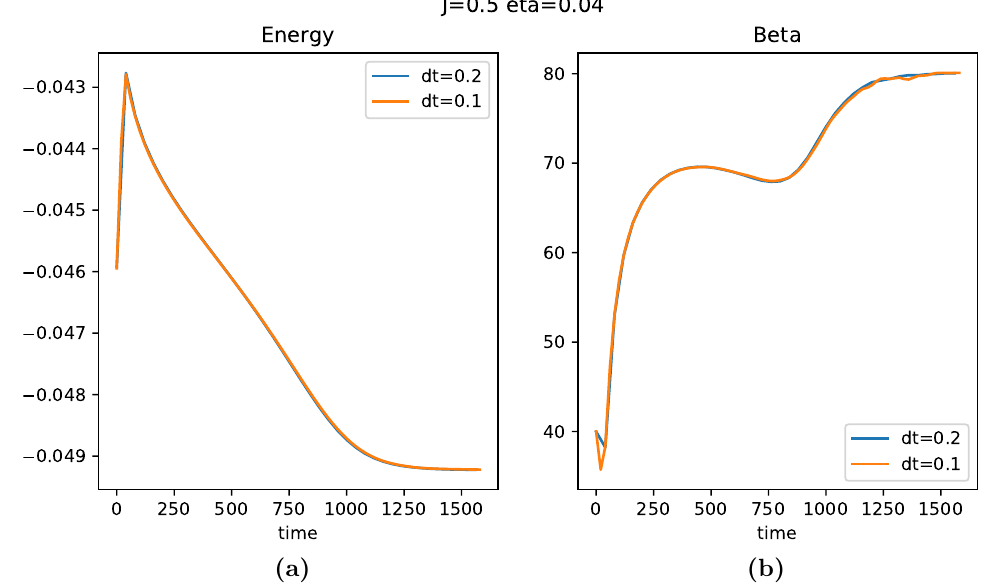
Figure 7 . Numerical results for J = 0 . 5 and µ = 0 . 05 , β B = 80 and timesteps dt = 0 . 2 , 0 . 1 .